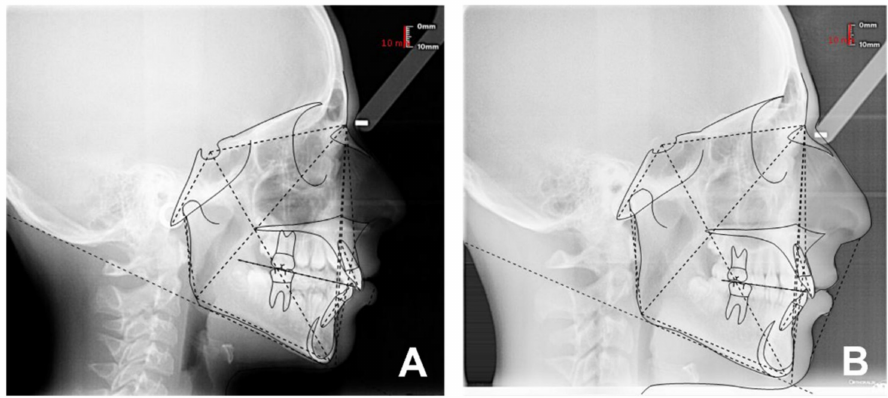
Figure 2. ( A , B )—Patient F.V. cephalometric tracings, before ( A ) and after ( B ) treatment.